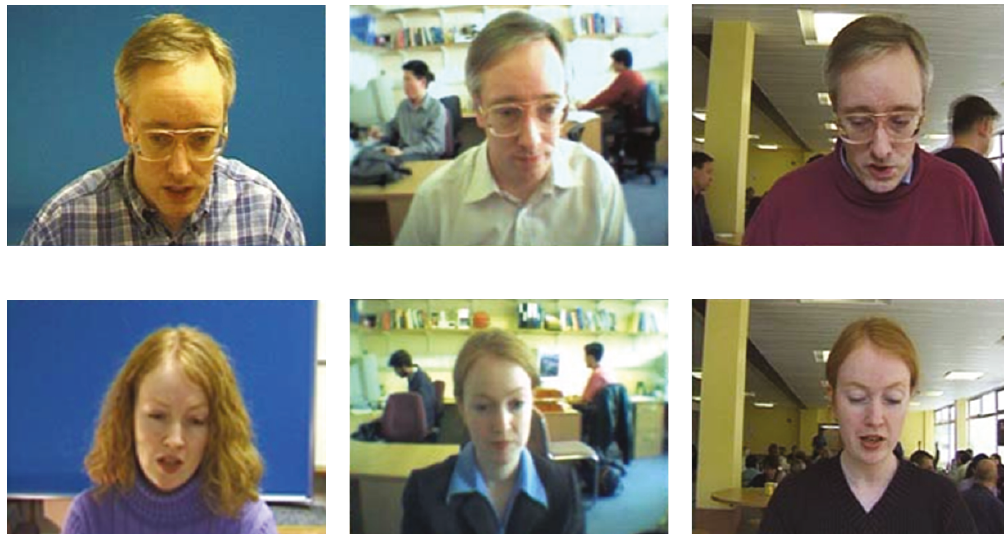
Figure 1: Screenshots from the BANCA database for two subjects in all three scenarios:Controlled (left), degraded (middle), and adverse